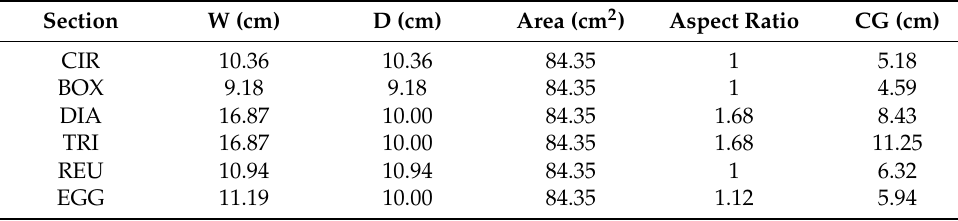
Table 1. Geometric parameters of the cross